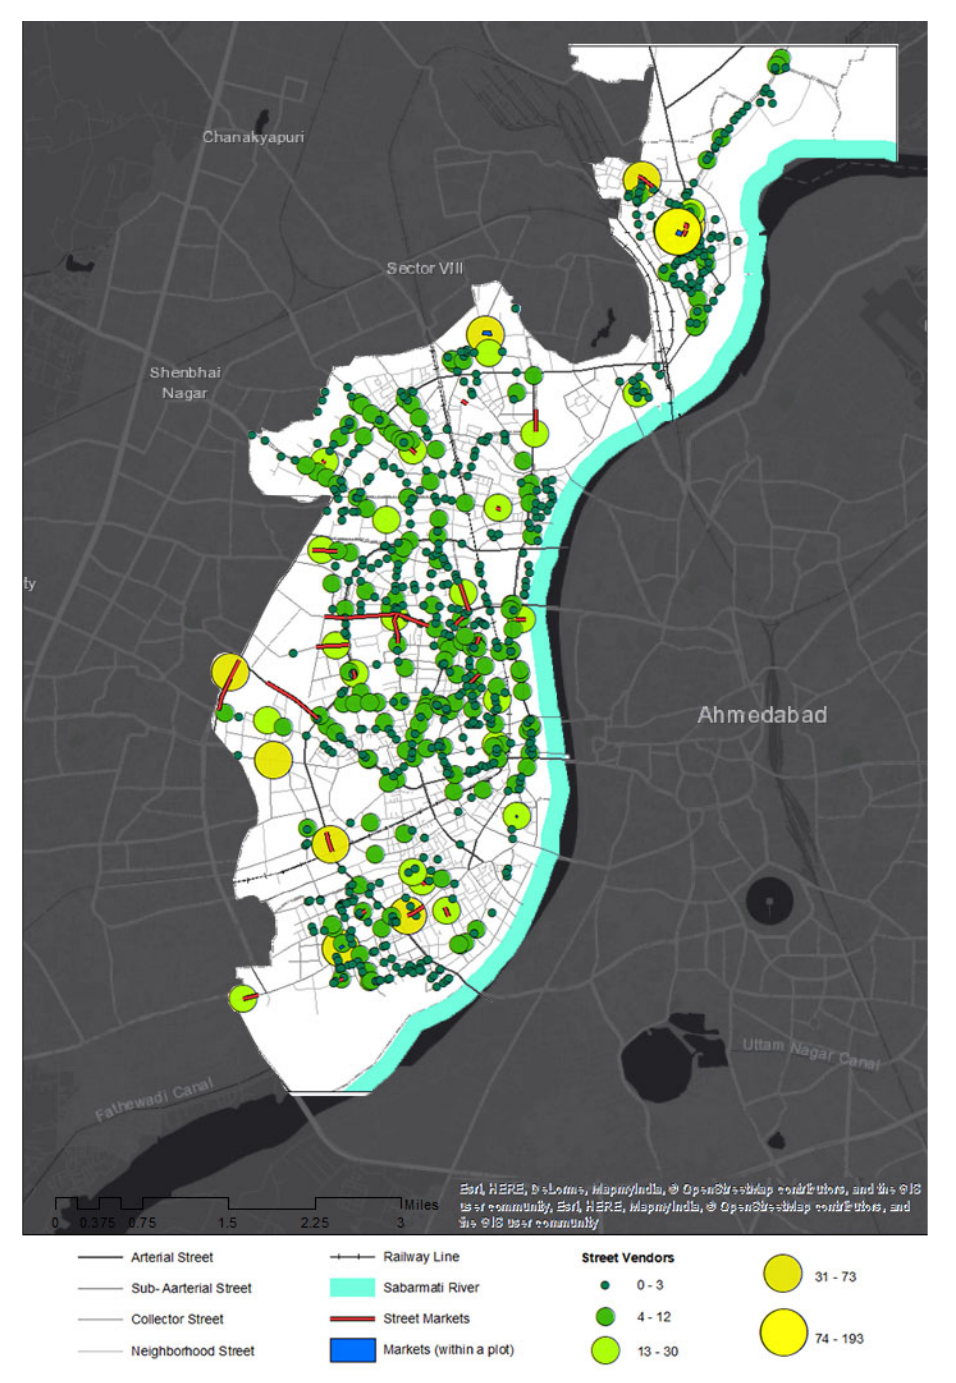
Figure 2. Street and cluster market map. Source: field work in Round